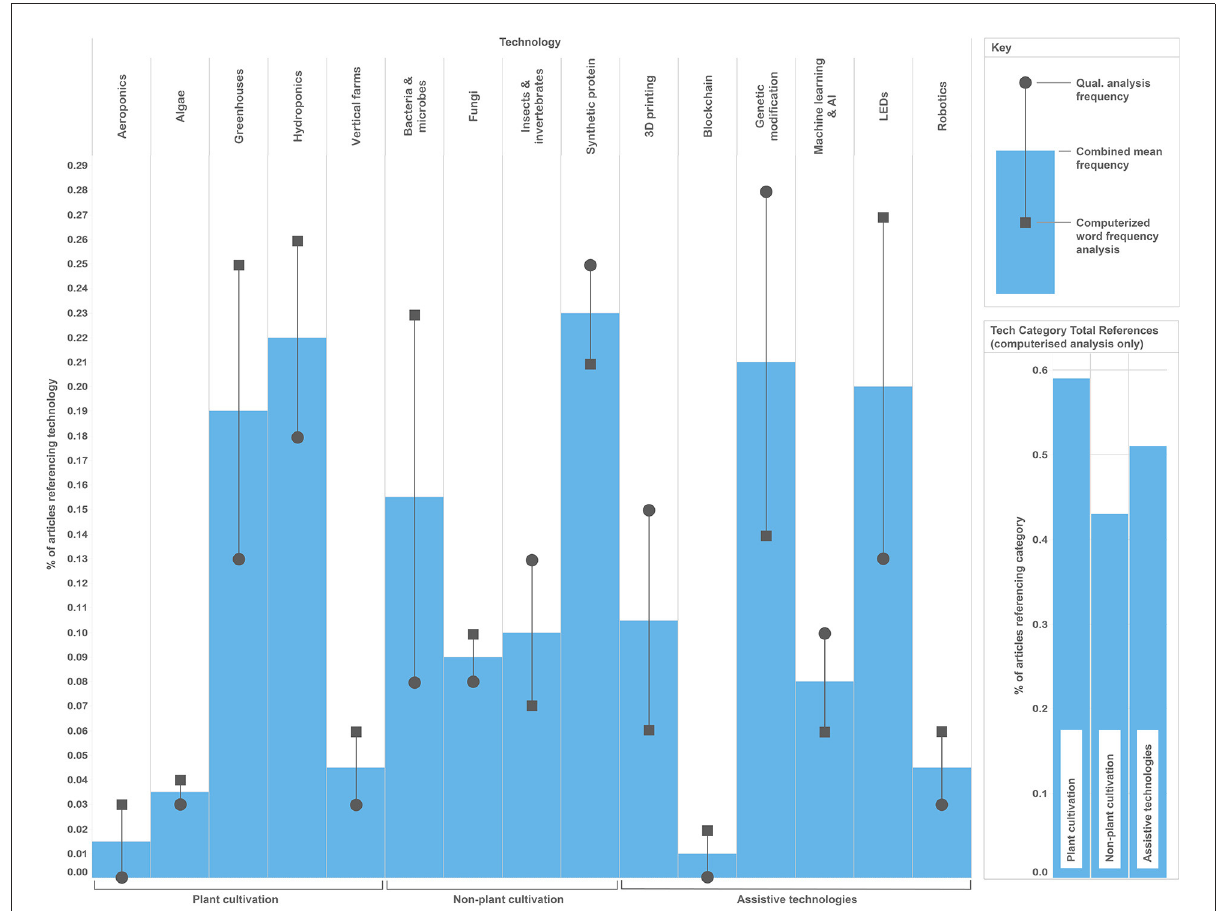
FIGURE2 Bar chart showing the percentage of articles in both the deep reading and word frequency analyses that reference a specific food growth technology, further categorized by type of technology (plant cultivation, non-plant cultivation, and assistive growing technologies). Type totals are displayed on the separate bar chart to the right. Variance between the deep reading analysis and computerized word frequency analysis is depicted using whiskers and the mean of these two measures is depicted in the blue